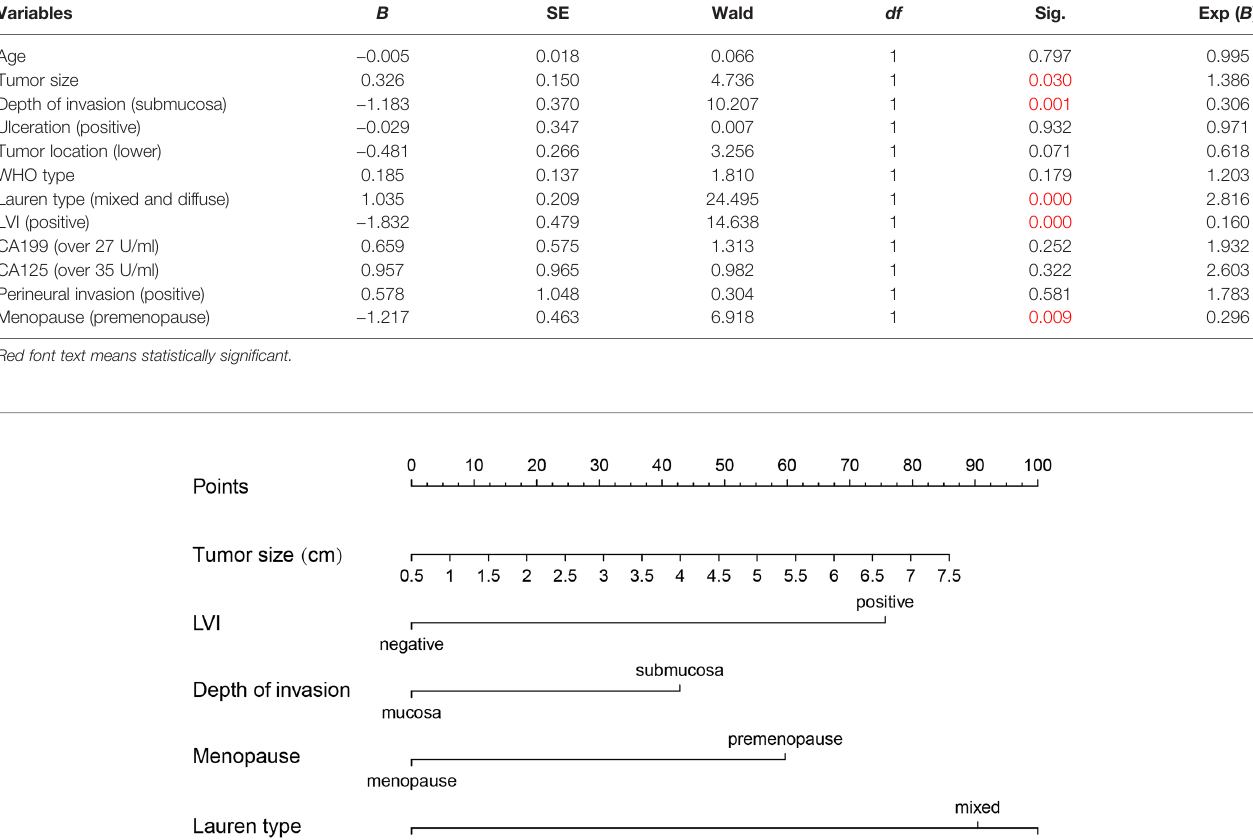
TABLE 3 | Multivariate analysis for LNM in female training set with EGC. Variables